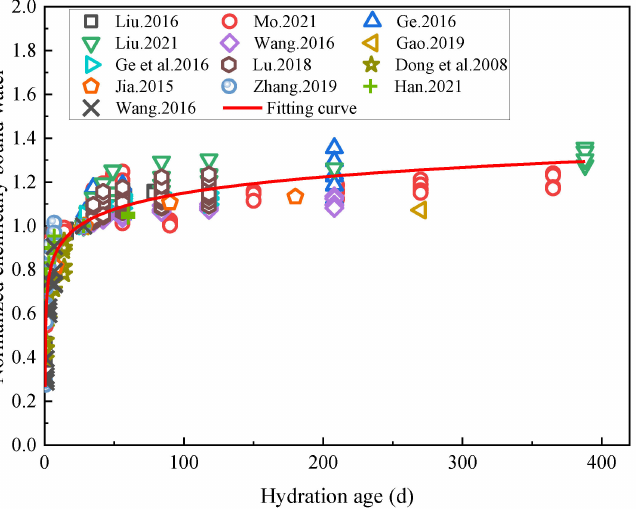
Figure 11. Variation curve of the chemically bound water content with hydration age after normaliza- tion